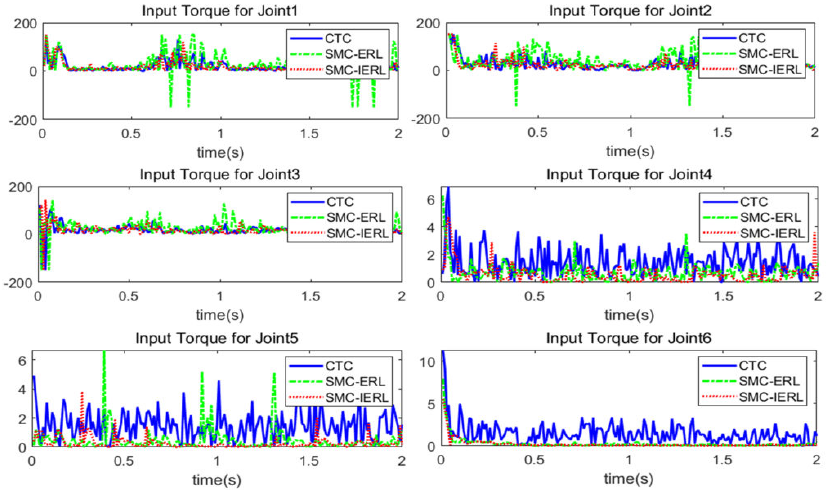
Figure 11. In the non-uniform circular trajectory experiment without considering disturbance signal, the output torque of each joint obtained by the three control algorithms is compared.